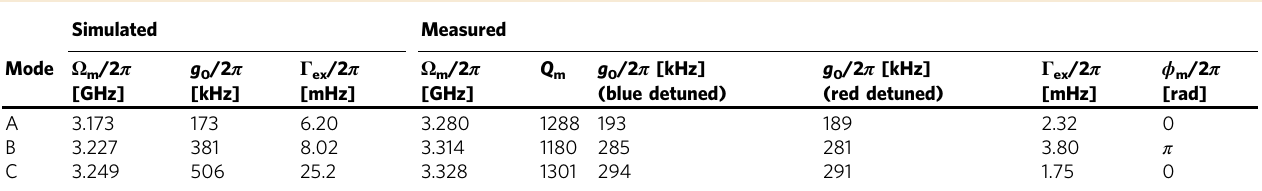
Optomechanical characterization . The optical cavity mode is fi rst interrogated in re fl ection with a tunable diode laser at low power (~130 nW) to determine the resonance frequency ω o and the loaded quality factor Q . For a Lorentzian resonance, re fl ection from the cavity as a function of detuning Δ = ω L −